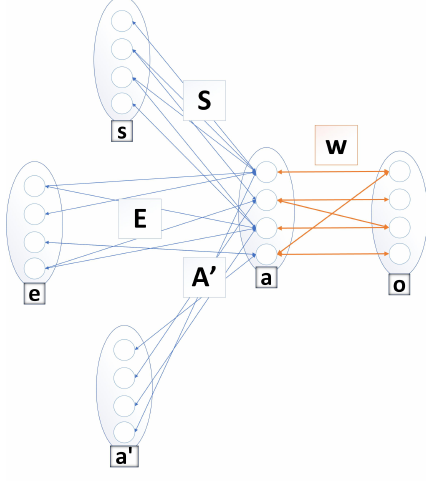
Figure 1. Illustrative network representation of a production line. The definitions of the symbols are given in Table